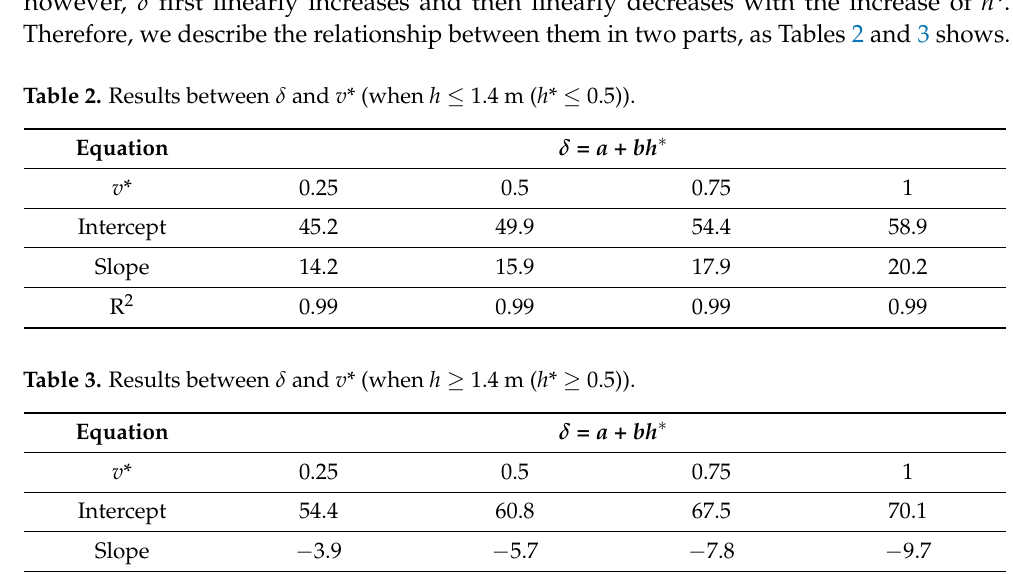
Table 1. Results between δ and v *.